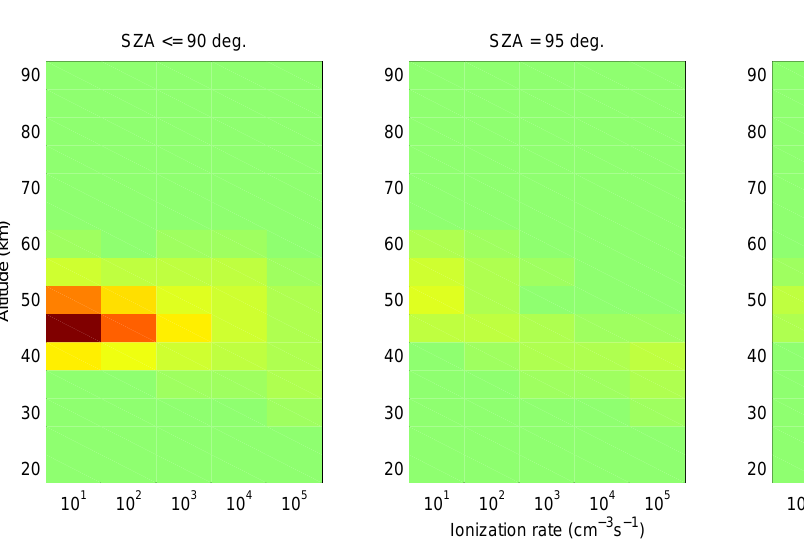
/Q for October 3